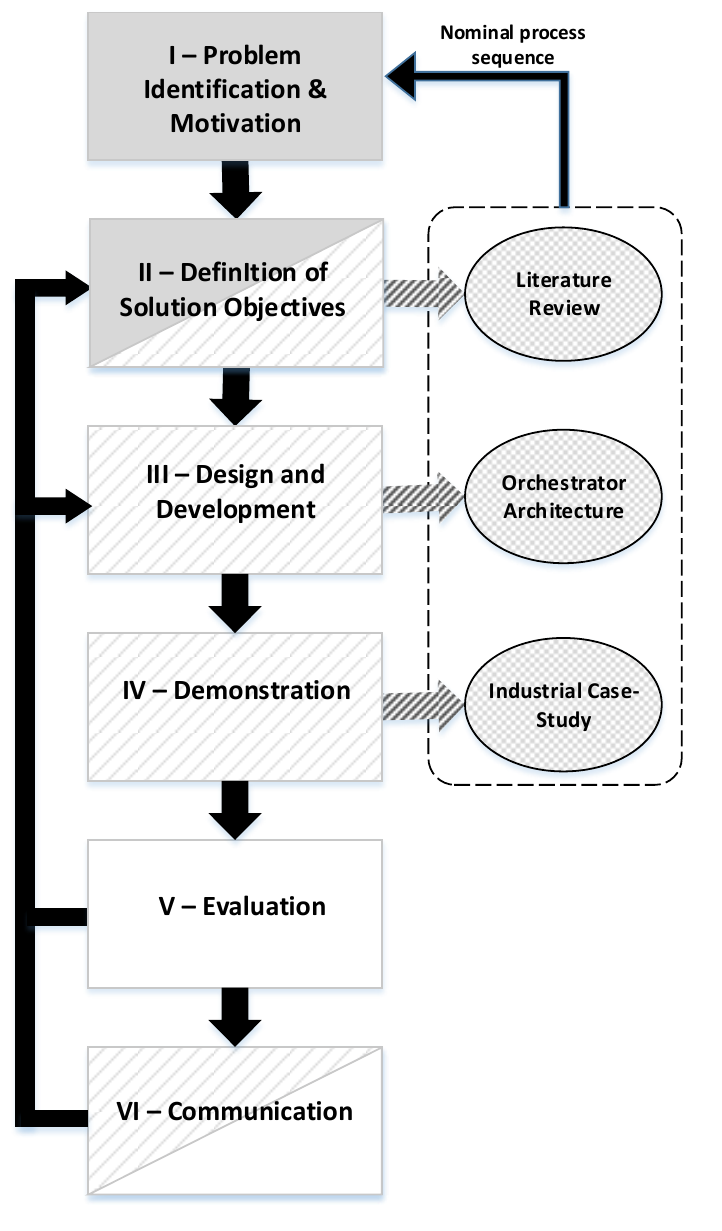
Figure 1. DSR methodology process model.